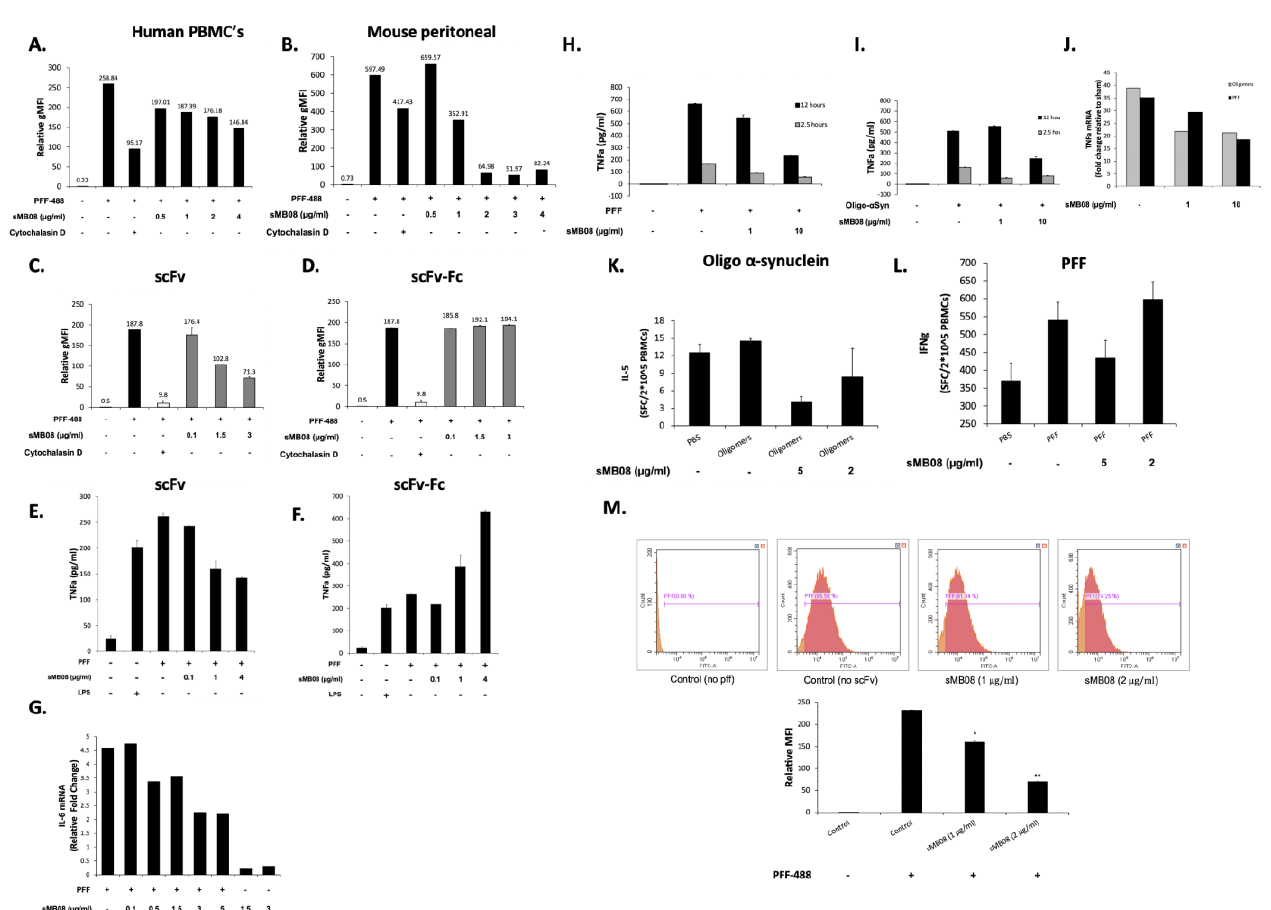
Figure 3. sMB08 ameliorates neuroinflammation and facilitates misolded- α Syn degradation ( A ) sMB08 attenuates uptake in a dose dependent manner of fluorescent PFF in human PBMCs. The y -axis represents the relative geometric mean (gMFI) measured by flow cytometry; ( B ) sMB08 attenuates uptake in a dose dependent manner of fluorescent PFF in mouse peritoneal macrophages. The y -axis represents the relative geometric mean (gMFI) measured by flow cytometry; sMB08 ( C ) attenuates uptake a dose dependent manner of fluorescent PFF compared to sMB08-Fc ( D ) in microglia cells (BV2); ( E ) sMB08 reduces TNF α protein levels in mouse microglia BV-2 cells compared to ( F ) sMB08-Fc elevates TNF α protein levels. ( G ) sMB08 attenuates IL-6 mRNA levels in mouse mi- croglia BV-2 cells. Real-time PCR was done in cell homogenates. The y -axis represents the fold-change in expression compared to no treatment (cells only). GAPDH was used as “housekeeping” gene; sMB08 attenuates inflammatory cytokines in human PBMCs induced by α Syn PFF and oligomers. PBMCs were activated with PFF ( H ) and oligomers ( I ) for 2.5 h or 12 h to and TNF α was measured ( J ) sMB08 attenuates inflammation in human PBMCs induced by α Syn PFF and oligomers. PBMCs were activated with PFF ( K ) and oligomers ( L ) for 2.5 h to measure TNF α at the mRNA expression levels. Real-time PCR was done in cell homogenates. The y -axis represents the fold-change in expres- sion compared to no treatment (cells only). GAPDH was used as “housekeeping” gene; ( M ) sMB08 lowers fluorescent PFF levels in a dose dependent manner in neuronal cells (SH-SY5Y). The y -axis represents the relative geometric mean (gMFI) measured by flow cytometry. ** p < 0.002, * p < 0.05. sMB08 down-regulates (in a dose dependent manner) TNF- α produced by